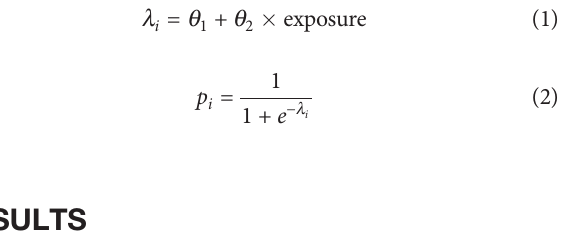
Table 1 . 49% (42/81) of the patients received 800 mg/day of PCZ on the fi rst day of treatment. All PCZ concentrations